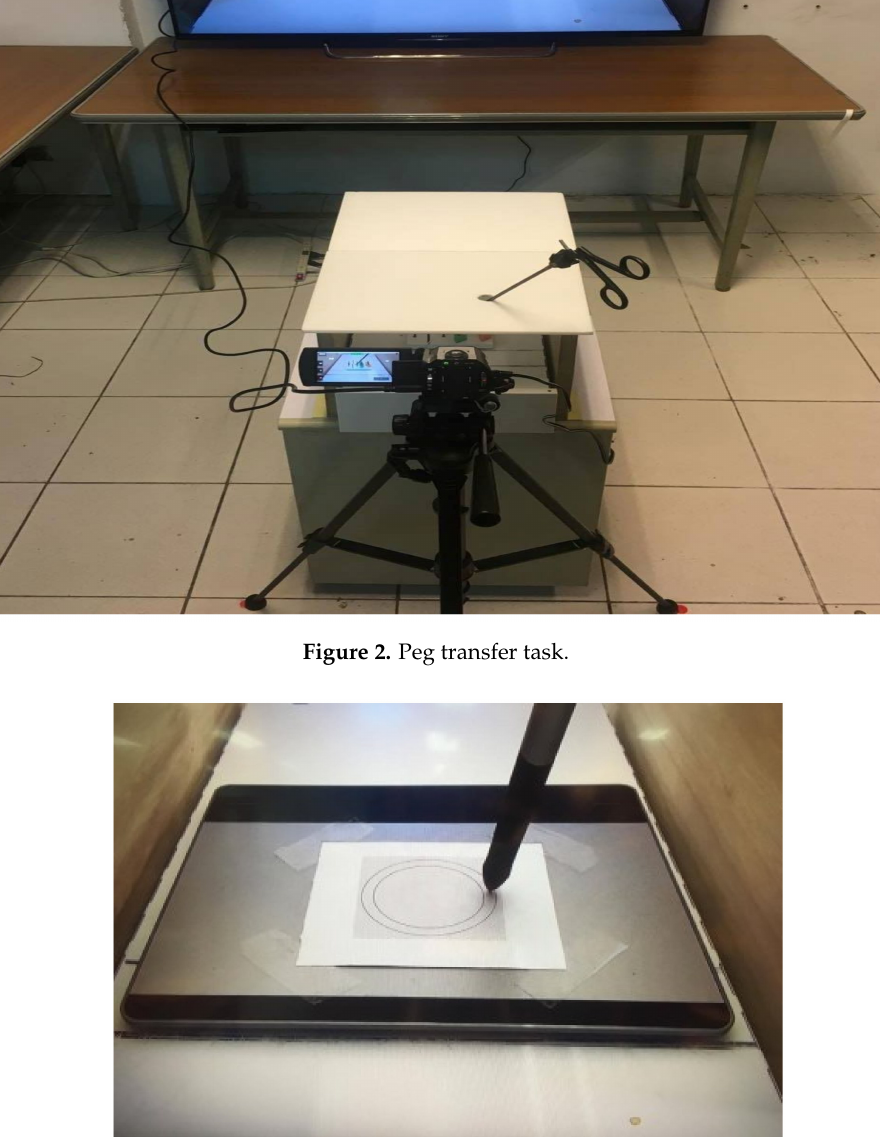
Figure 3. The digitizer tablet and modified Endo Babcock clamp with a digital pen used in the circle-tracing